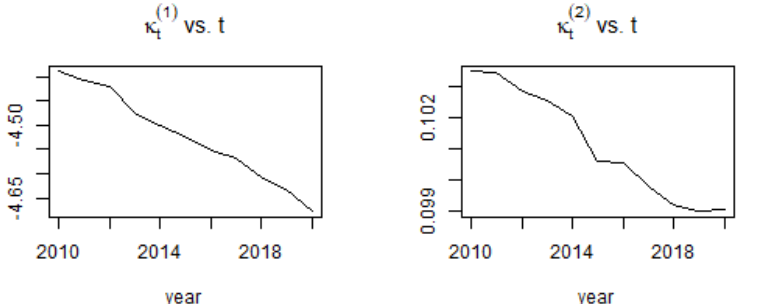
Figure 5. CBD Parameters Fitted to the Ghana Pension Population for Ages 40–83 and the Period 2010–2020.